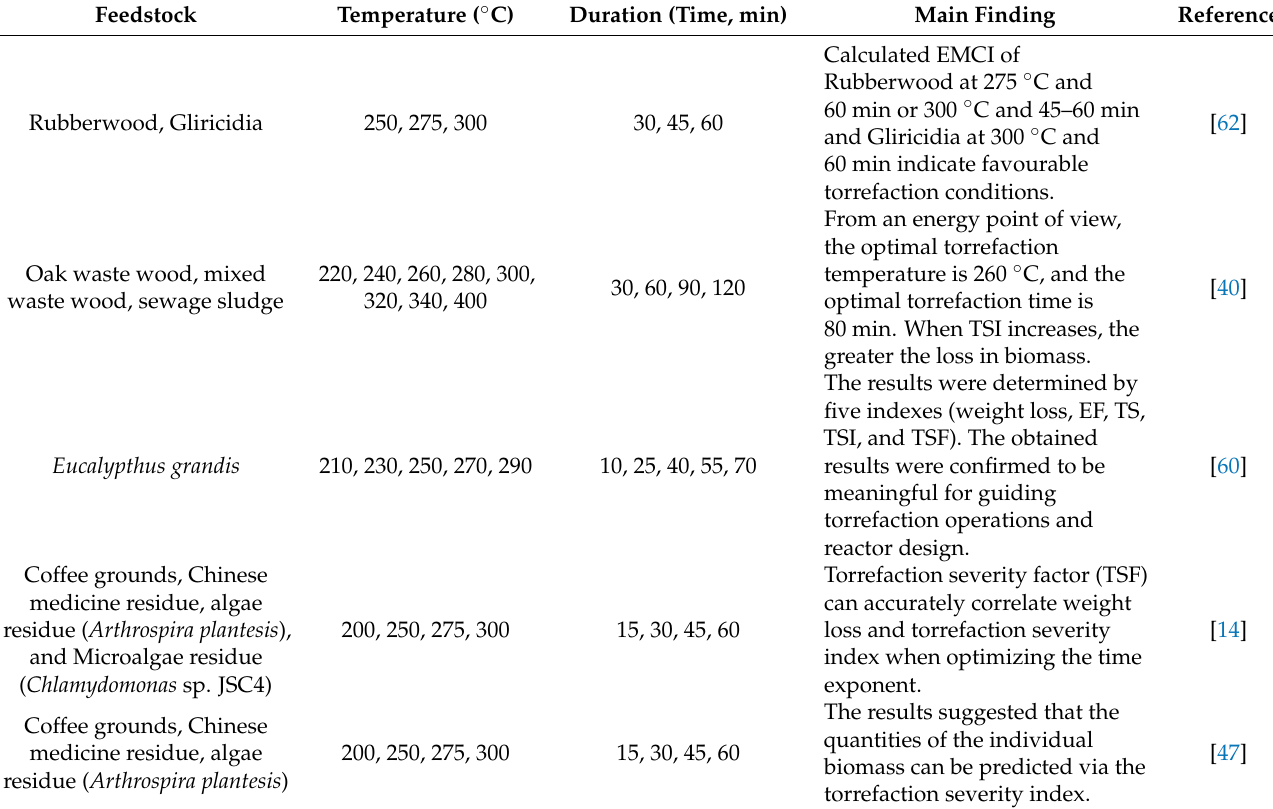
Table 1. Past studies on the torrefaction process and